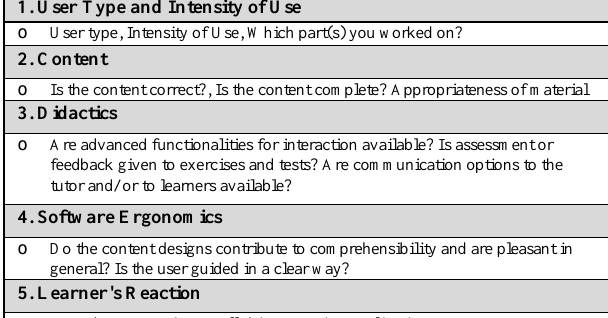
Table 5: Questionnaire for evaluating the prototype system (adopted from Katterfeld and König 2008))